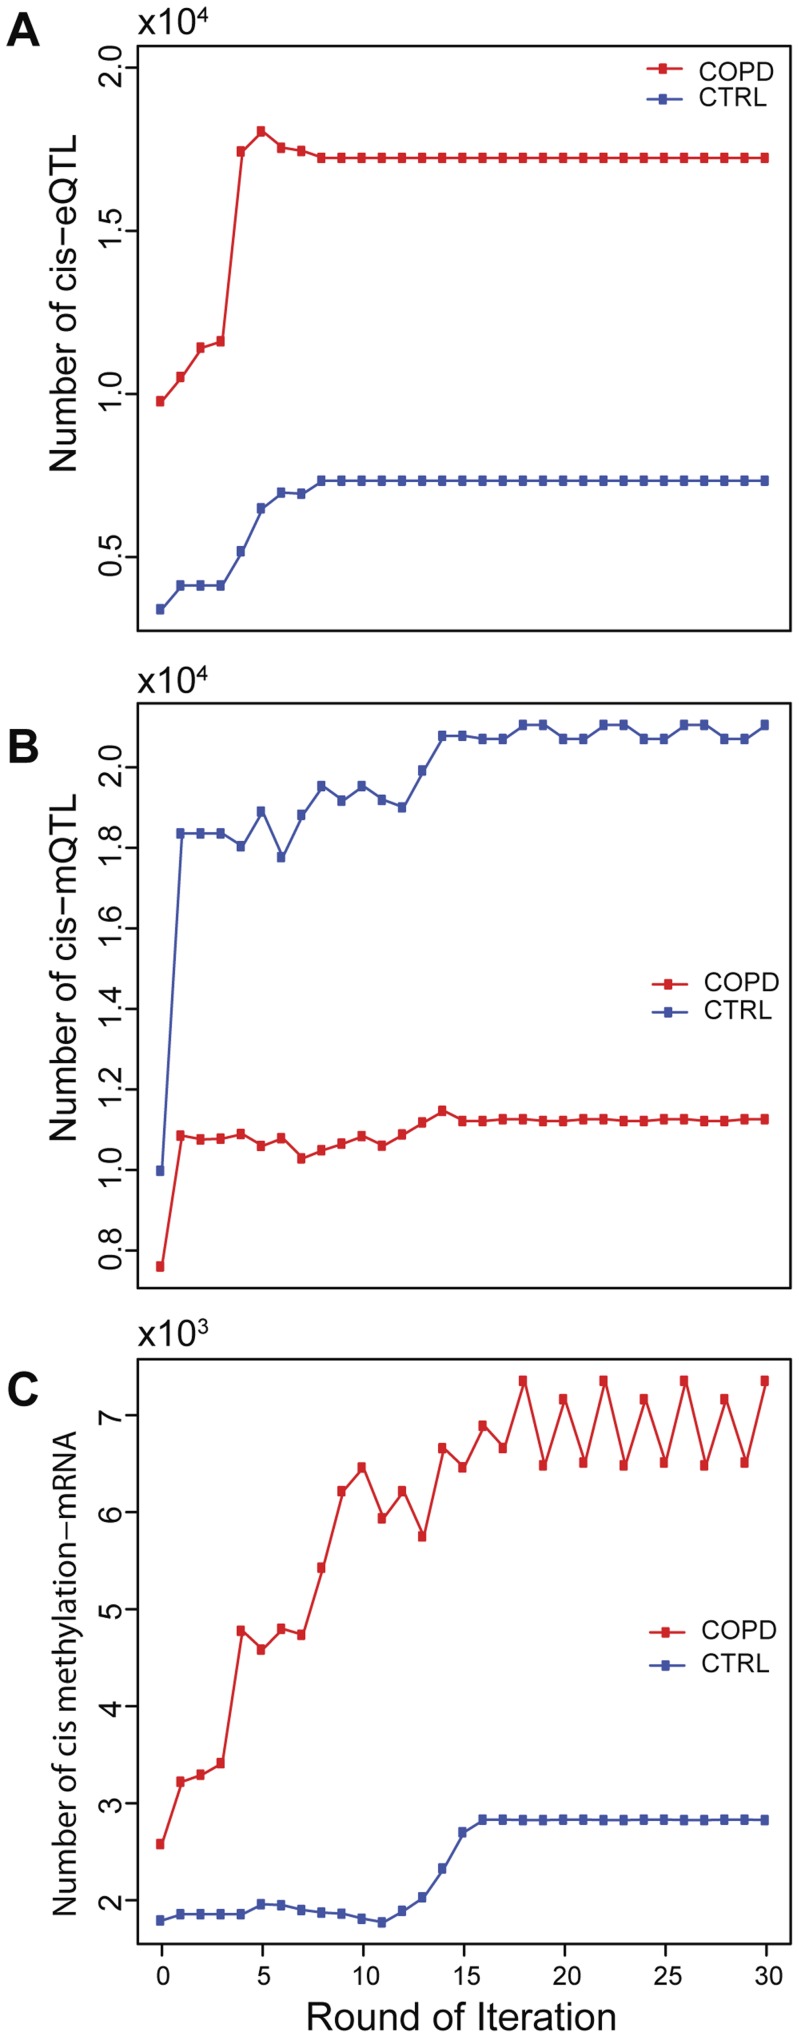
Assessment of sample alignment quality.The number of cis pairs is counted after each round of alignment. The number of cis pairs increased markedly after alignment in both the CTRL and COPD sets. The exact numbers of cis-pairs are listed in Table S2. A) cis-eQTLs. B) cis-mQTLs. C) cis mRNA-methylation pairs.